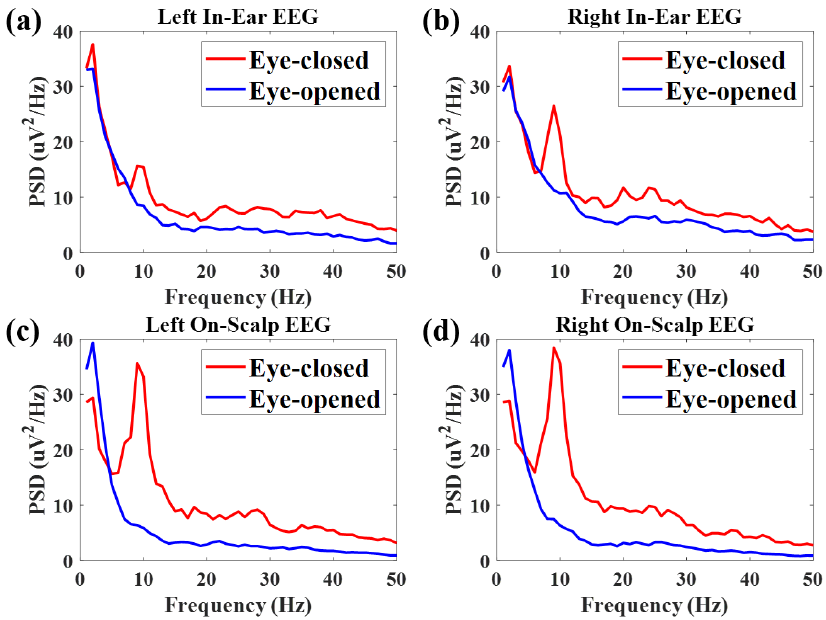
Figure A1. Alpha attenuation effect. Red lines denote averaged power spectral densities (PSDs) during eyes-closed resting state and blue lines are averaged PSDs during eyes-open resting state from ( a ) left in-ear EEG channel, ( b ) right in-ear EEG channel, ( c ) left on-scalp EEG channel, and ( d ) right on-scalp EEG channel.